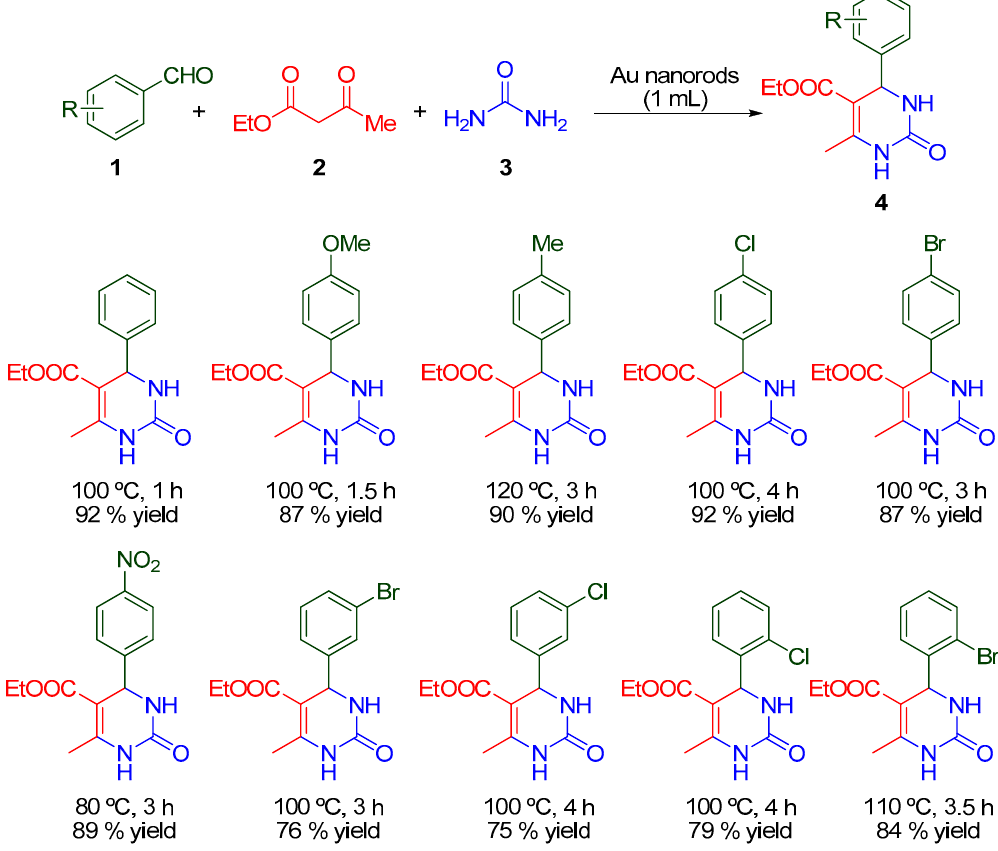
Scheme 1. Biginelli reaction catalyzed by Au nanorods.